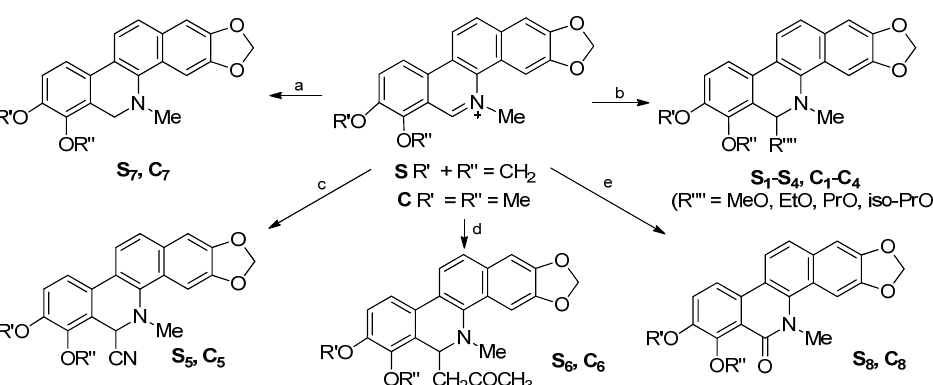
– S and C – C 1 8 1 8